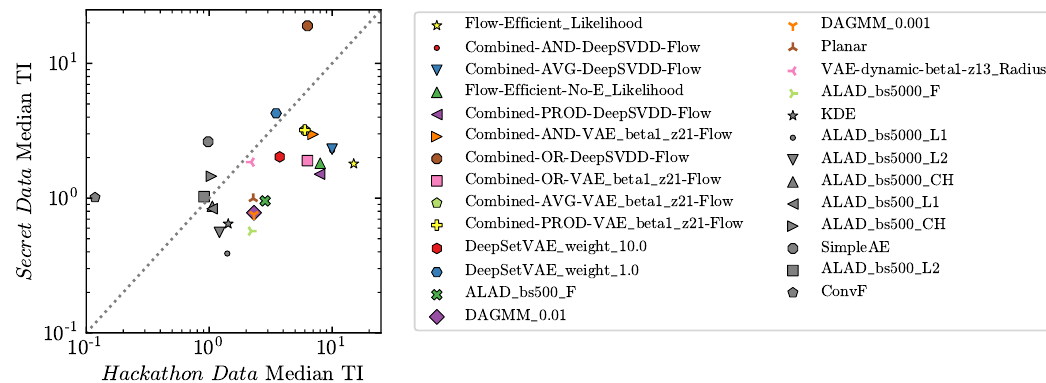
Figure 24: The median TI scores for the Hackathon and Secret datasets along the x - and y -axis, respectively. The point marked with color were chosen as having median TI > 2 on the Hackathon data, and the grey points are included as reference models.